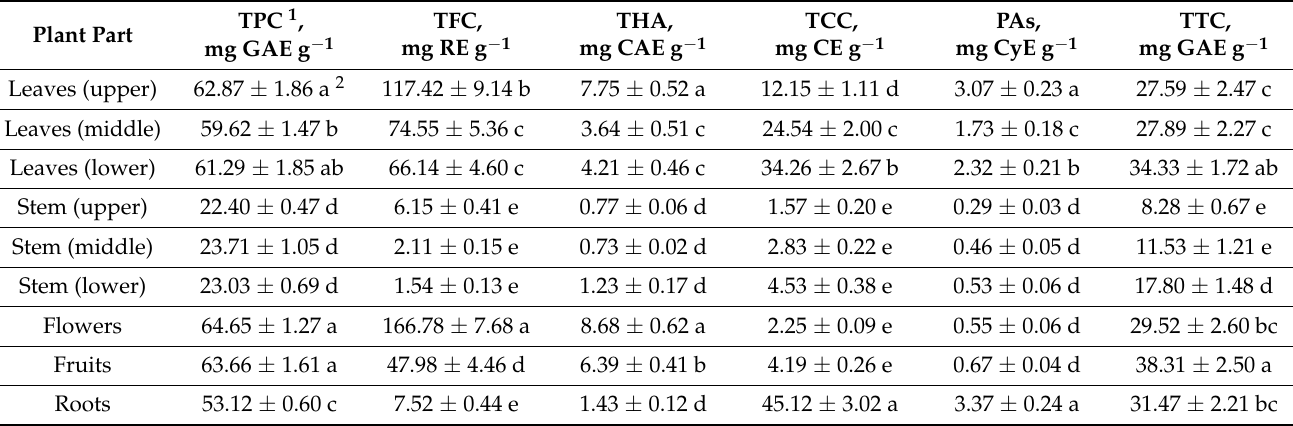
Table 1. Content of some groups of phenolic compounds in the different parts of